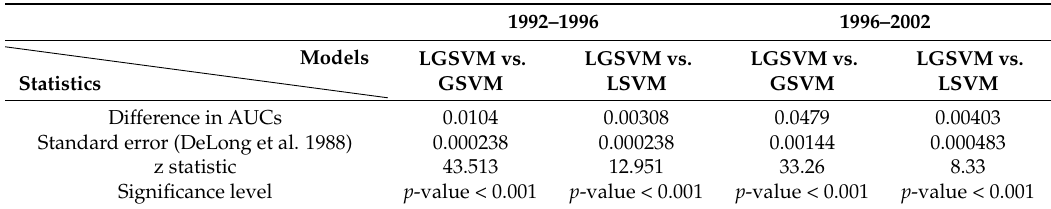
Table 4. Assessment of the significance of differences among the AUCs of the ROC curves obtained for the GSVM, LSVM and LGSVM models for the periods of 1992–1996 and 1996–2000.